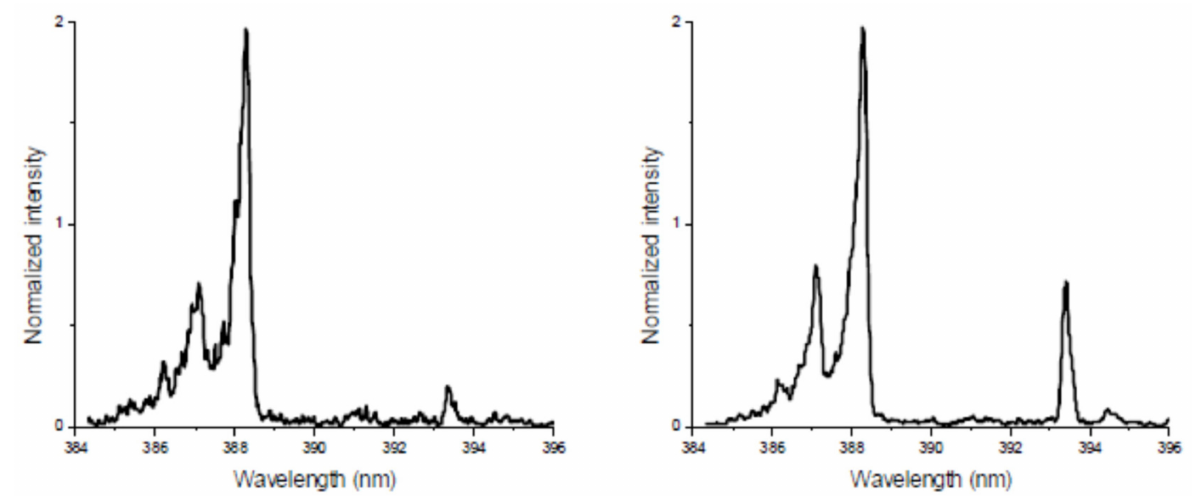
Figure 49. Spectrum of CN violet ∆ v = 0 (Case 3 of Table 5): Left: zone 1; Right: zone 2 (from [52]).